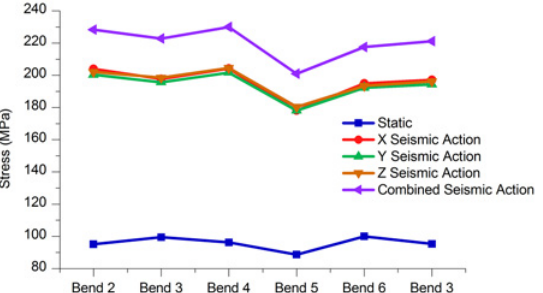
Fig 11. Stress of each bend under different working conditions.